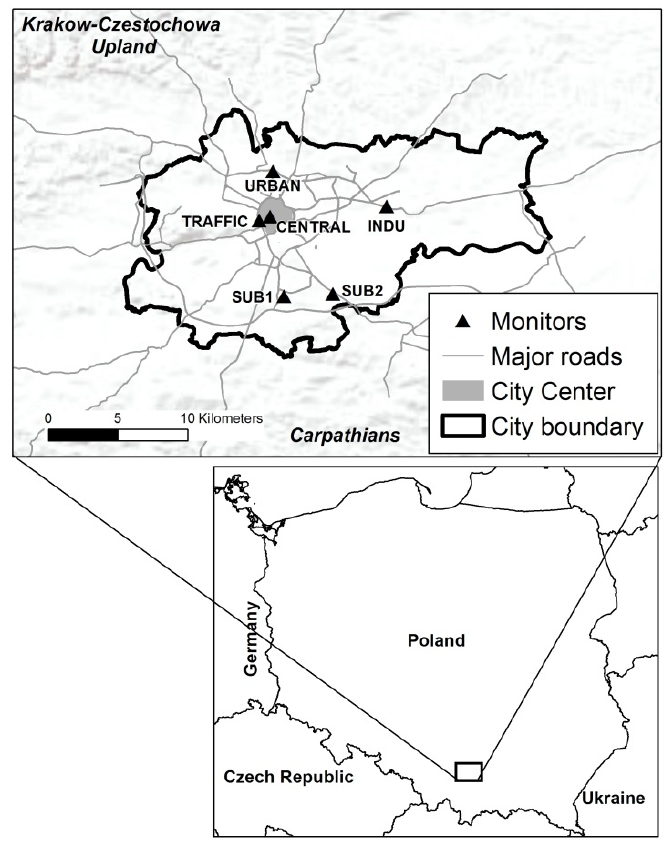
Figure 1. Six monitoring stations cover four districts. The city center is shown in